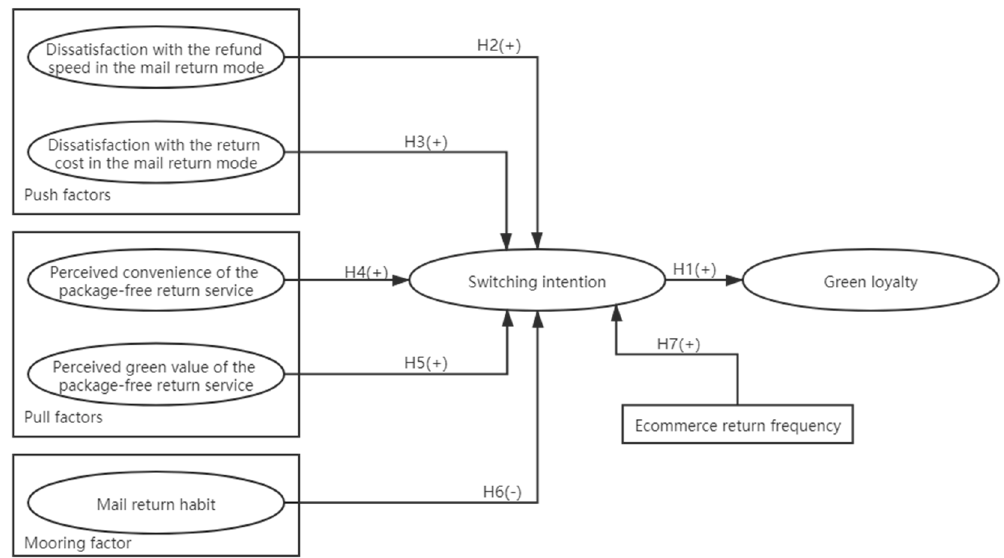
Figure 3. Research